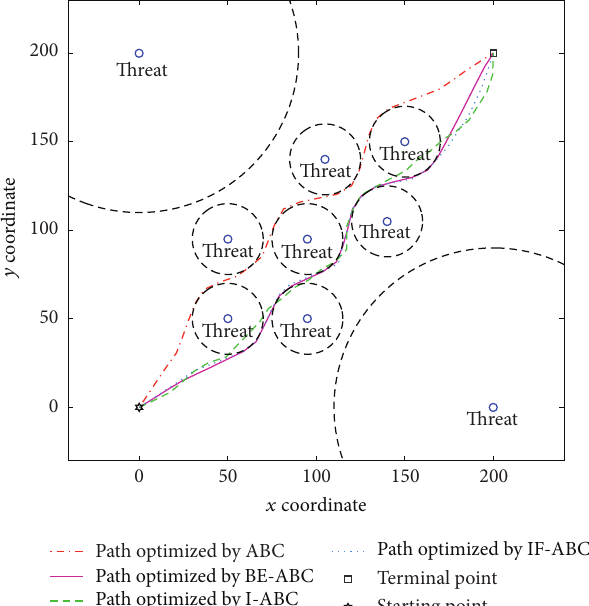
Figure 7: Comparative path planning results optimized by different ABC relevant algorithms in Case 2 ( 𝐷 = 30 and MCN = 1000 ).